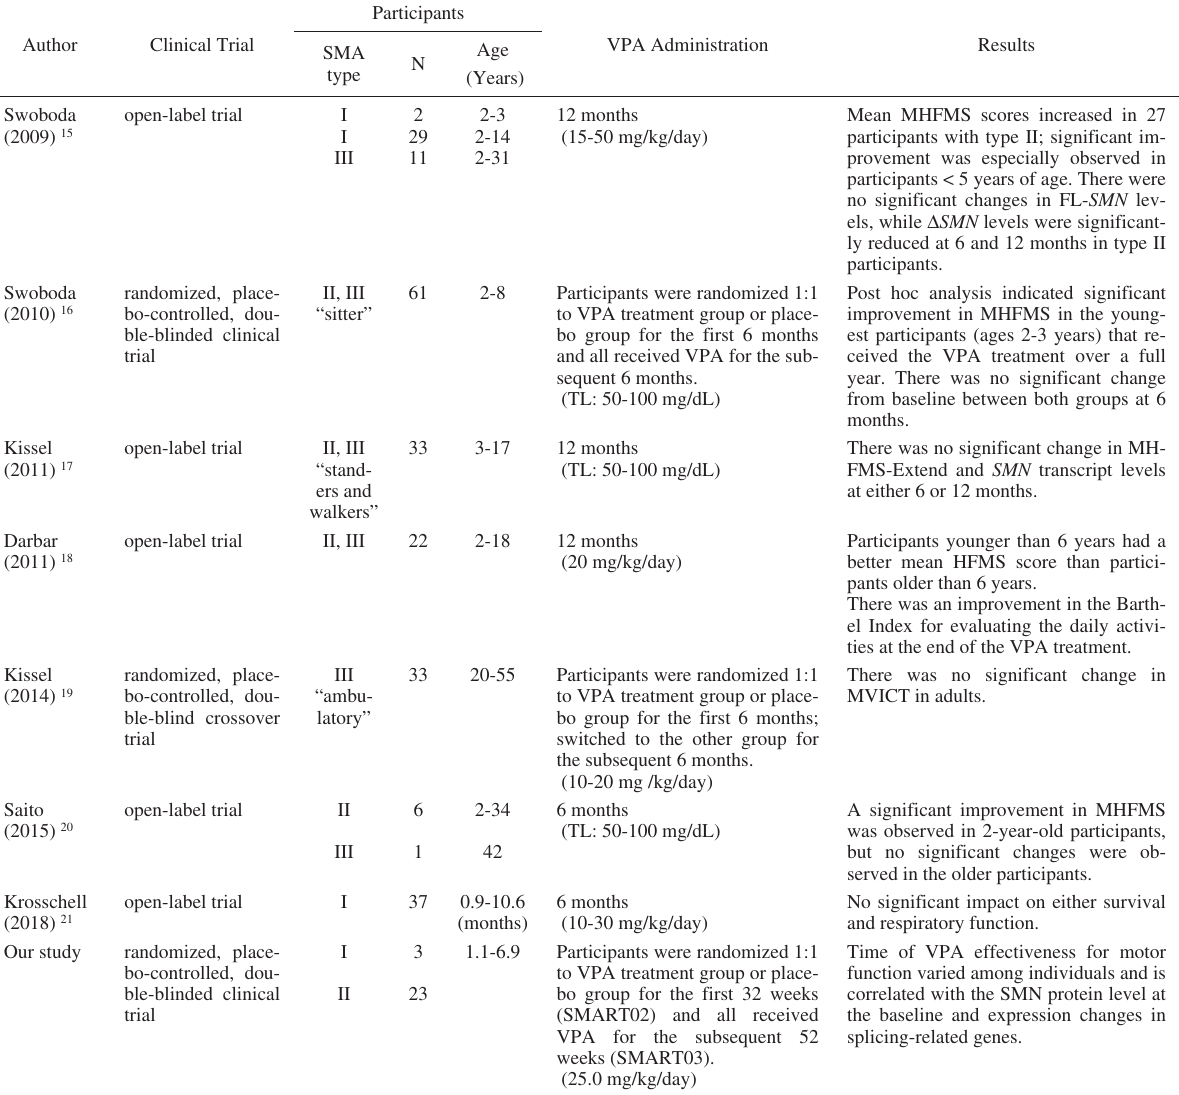
Table 3. Summary of previous clinical trials of VPA targeting SMA patients and the study